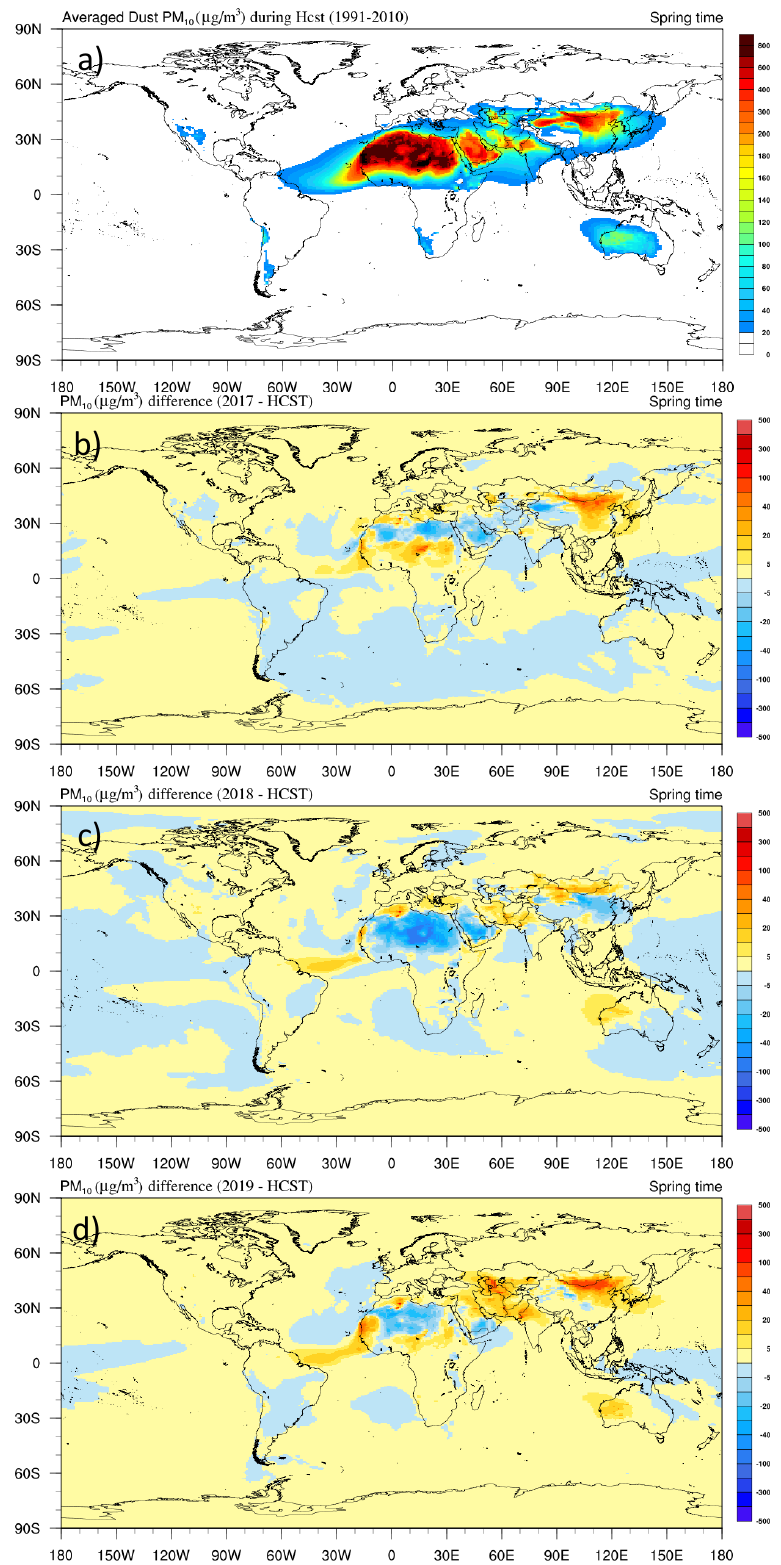
Figure 7. Springtime seasonal Asian dust forecasts using GloSea5-ADAM (2017–2019). ( a ) Springtime mean PM 10 mass concentrations in 20-year (1991–2010) hindcast and ( b ) springtime PM 10 mass concentration anomalies from 2017 to 2019 ( b – d ). Units: µg m −3 .